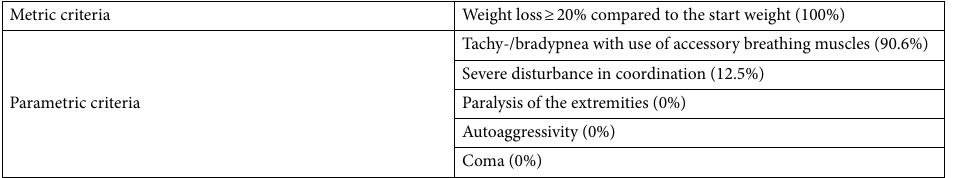
Table 1. Criteria for euthanasia. According to the Society of Laboratory Animal Science 47 , the following criteria were controlled on every day of the experiment. If one of them was fulfilled, the mouse was euthanized. (occurrence is signalized as percentage of all prematurely euthanized animals).